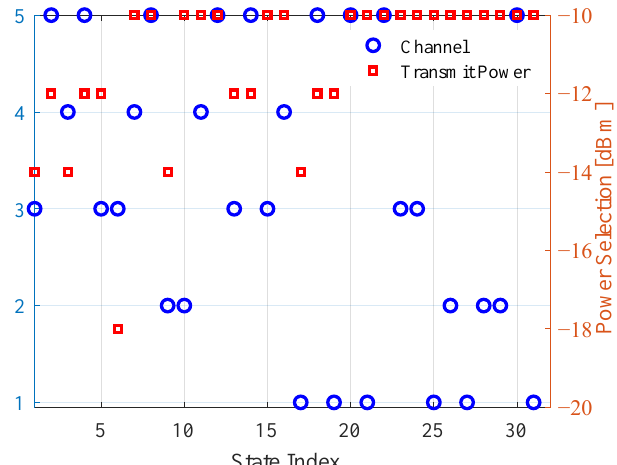
Figure 5. Learned Q-policy at convergence of the MAQL training for joint channel and power selection with s th = 2 dB.